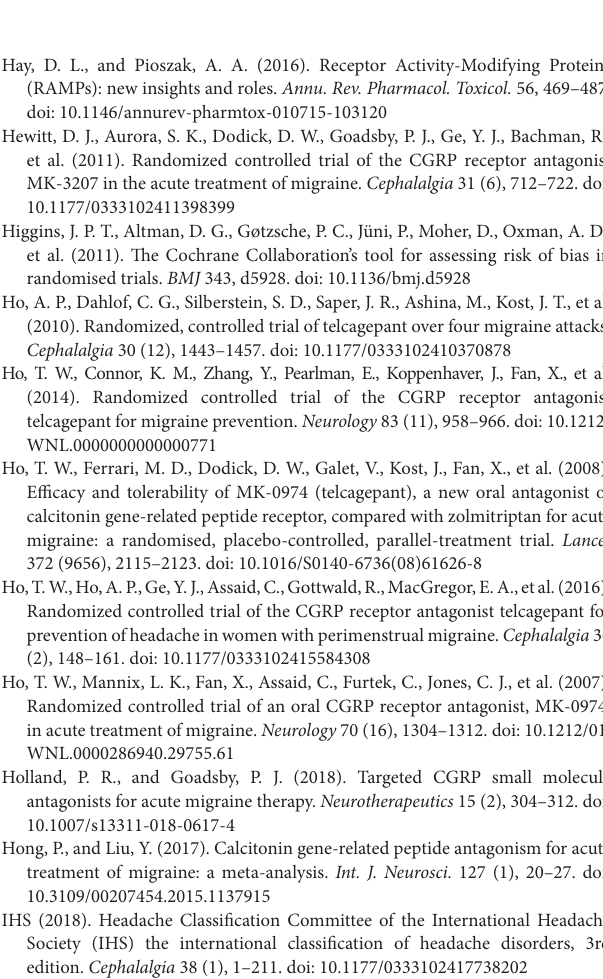
FIGURE S1 | Risk of bias summary for each risk of bias item for each included study. FIGURE S2 | Risk of bias graph for each risk of bias item presented as percentages across all included studies. TABLE S1 | Rank results. TABLE S2 | Assessment of heterogeneity and